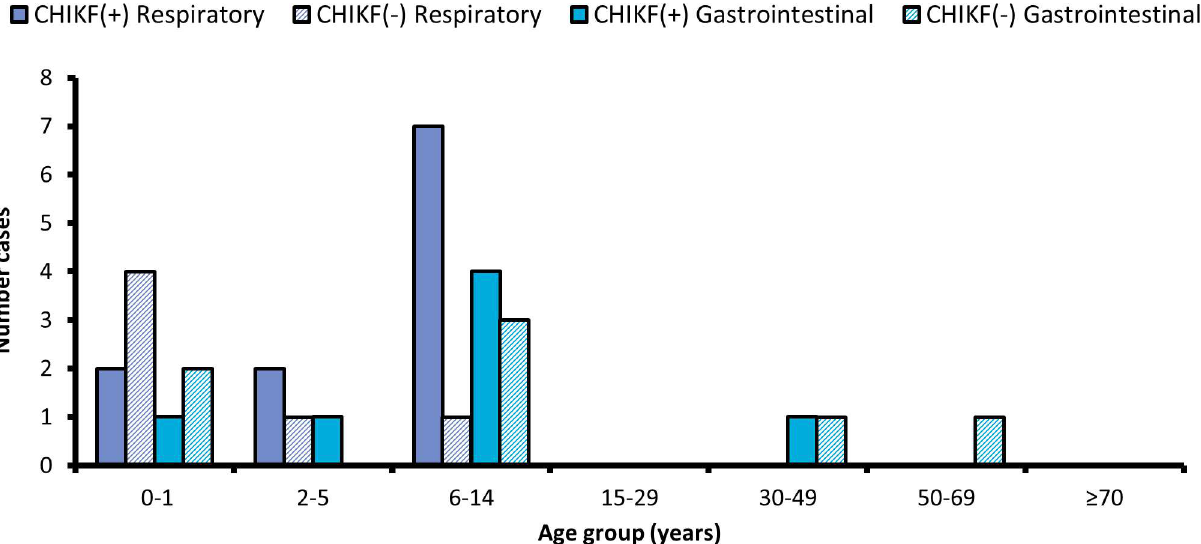
Fig 3. Distribution of respiratory and gastrointestinal symptoms by age. Serum from patients visiting an emergency clinic in the DR was tested for CHIKV RNA and IgM, and results were retrospectively matched to clinical features documentedby physicians.Childrenand young adults belowthe age of 15 were the primary demographicgroups presentingwith respiratoryand gastrointestinal symptoms for both CHIKF (+) (RNA-positive) and CHIKF(-) (both IgM and RNA